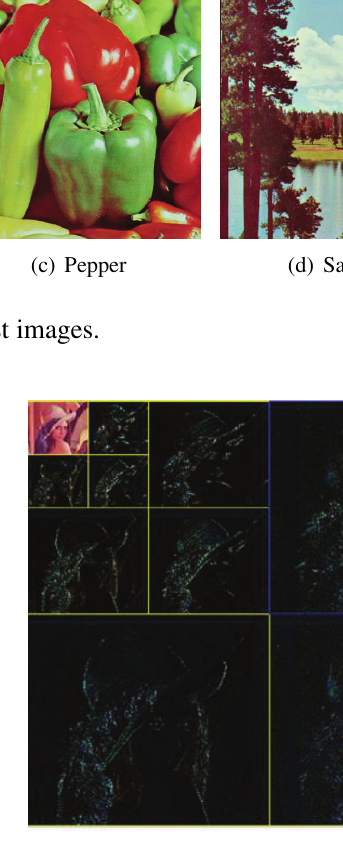
Figure 8: Three level decomposed host lena image using DWT.